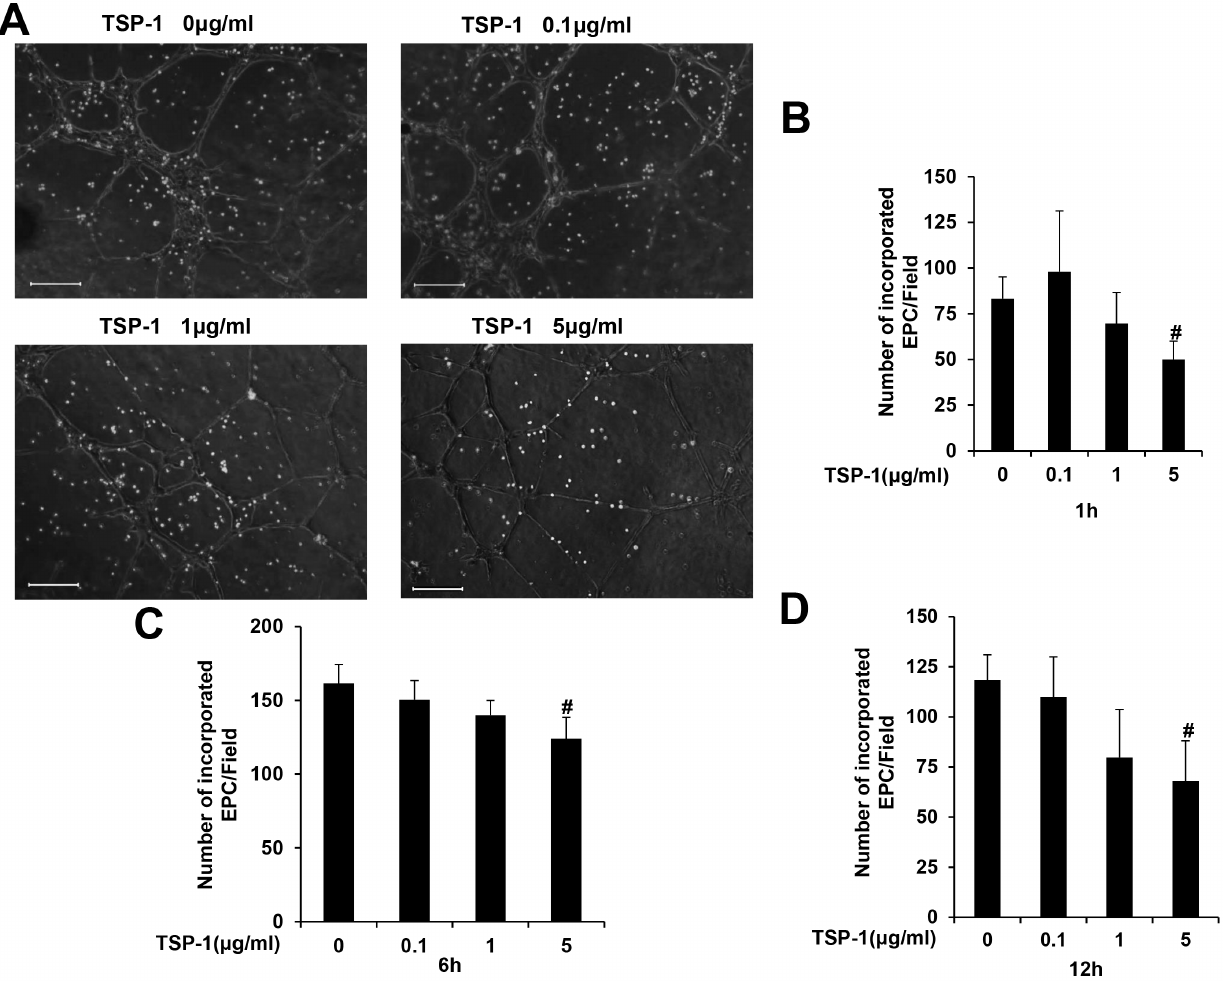
Figure 2. TSP-1 inhibited early EPCs incorporation into tube-like structure. (A) Early EPCs pretreated with TSP-1 at different concentrations for 1 hr were labeled with a DiI fluorescent marker(red) and coplated with HUVECs(transparent) to form tubule structures on Matrigel(Scale bar=200 m m,100 6 magnification). (B–D) Early EPCs pretreated with TSP-1 at different concentrations for 1 hr(B), 6 hrs(C), 12 hrs(D) were coplated with HUVECs on Matrigel. Quantifications of incorporated EPCs per field were presented as mean 6 S.D of three independent experiments ( # p , 0.05 versus no TSP-1 intervention).